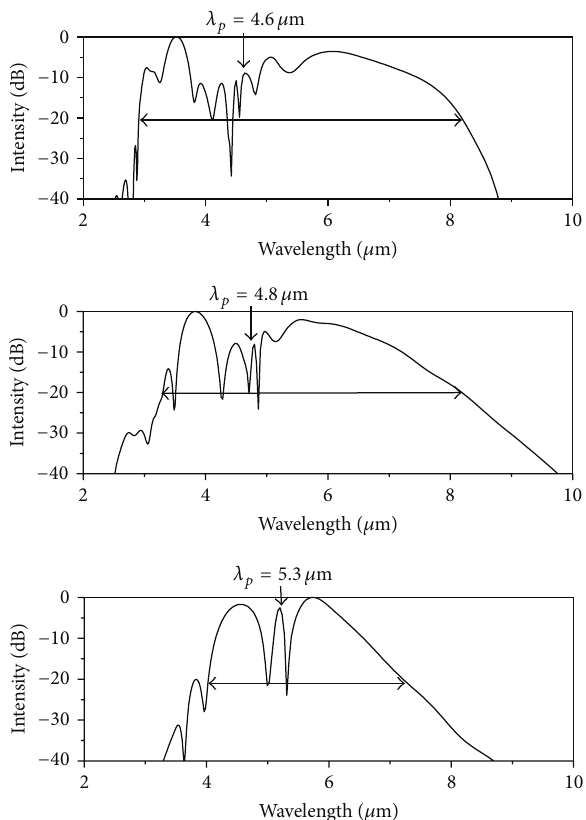
Figure 3: Output spectra for Λ = 3.5 𝜇 m (top), 4.5 𝜇 m (middle), and 5.5 𝜇 m (bottom). The input pulse has a FWHM of 160fs and a peak power of